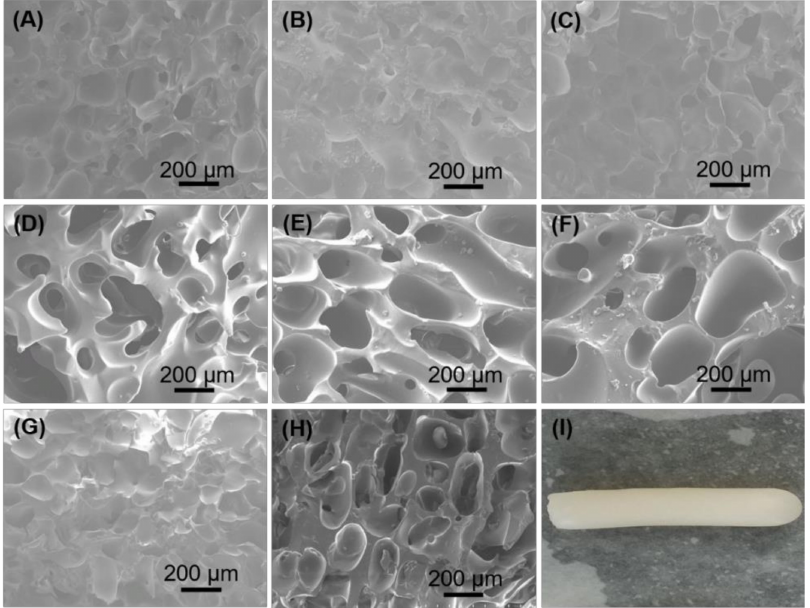
Figure 2. SEM images of the as-prepared cryogels ( A ): C-63p4, ( B ): C-65p4, C: ( C )-67p4; ( D ): C-63p2; ( E ): C-65p2, ( F ): C-67p2), ( G ): C-63p2 cryogel after the tenth cycle of oil absorption; ( H ): C-63p4